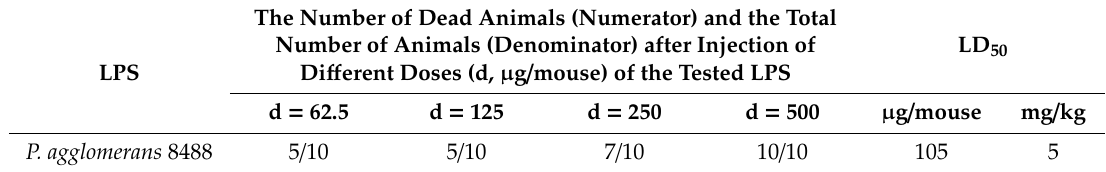
Table 4. Determination of toxicity of the P. agglomerans 8488 LPS.